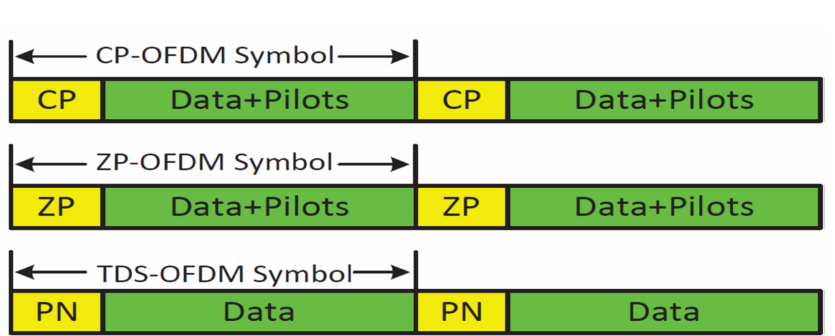
Figure 1. TDS ‐ OFDM, ZP ‐ OFDM and CP ‐ OFDM signal structure comparison in the time domain. Figure 1. TDS-OFDM, ZP-OFDM and CP-OFDM signal structure comparison in the time